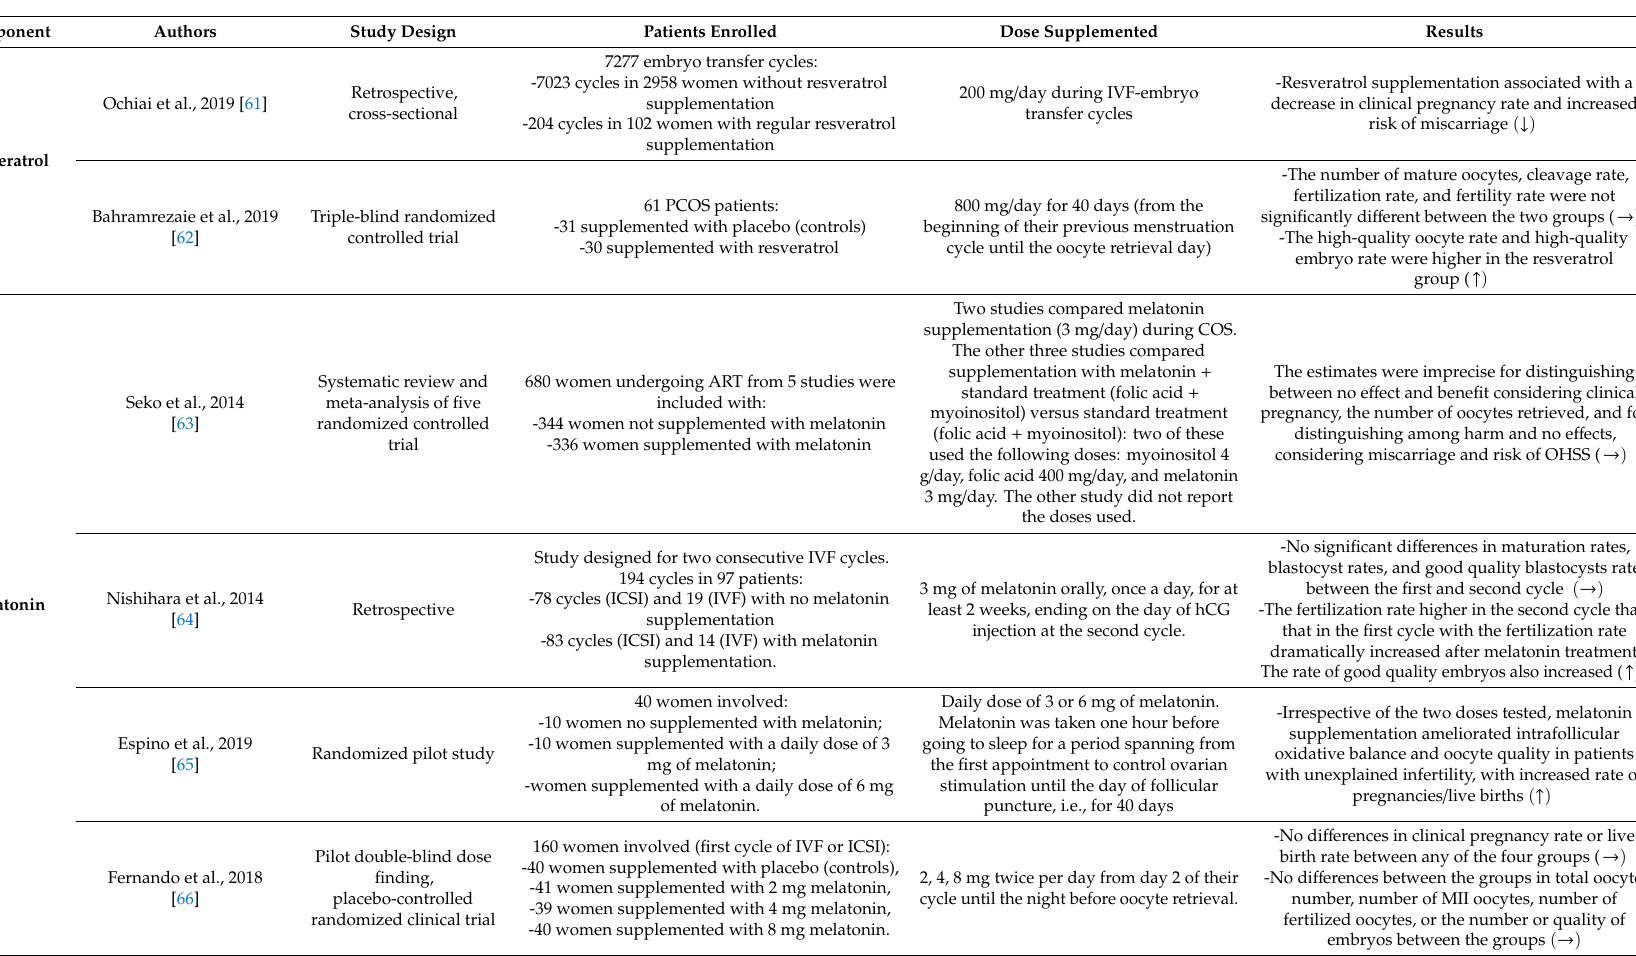
Table 2. Human clinical studies about antioxidants and vitamins during controlled ovarian stimulation (COS) for in-vitro fertilization (IVF)